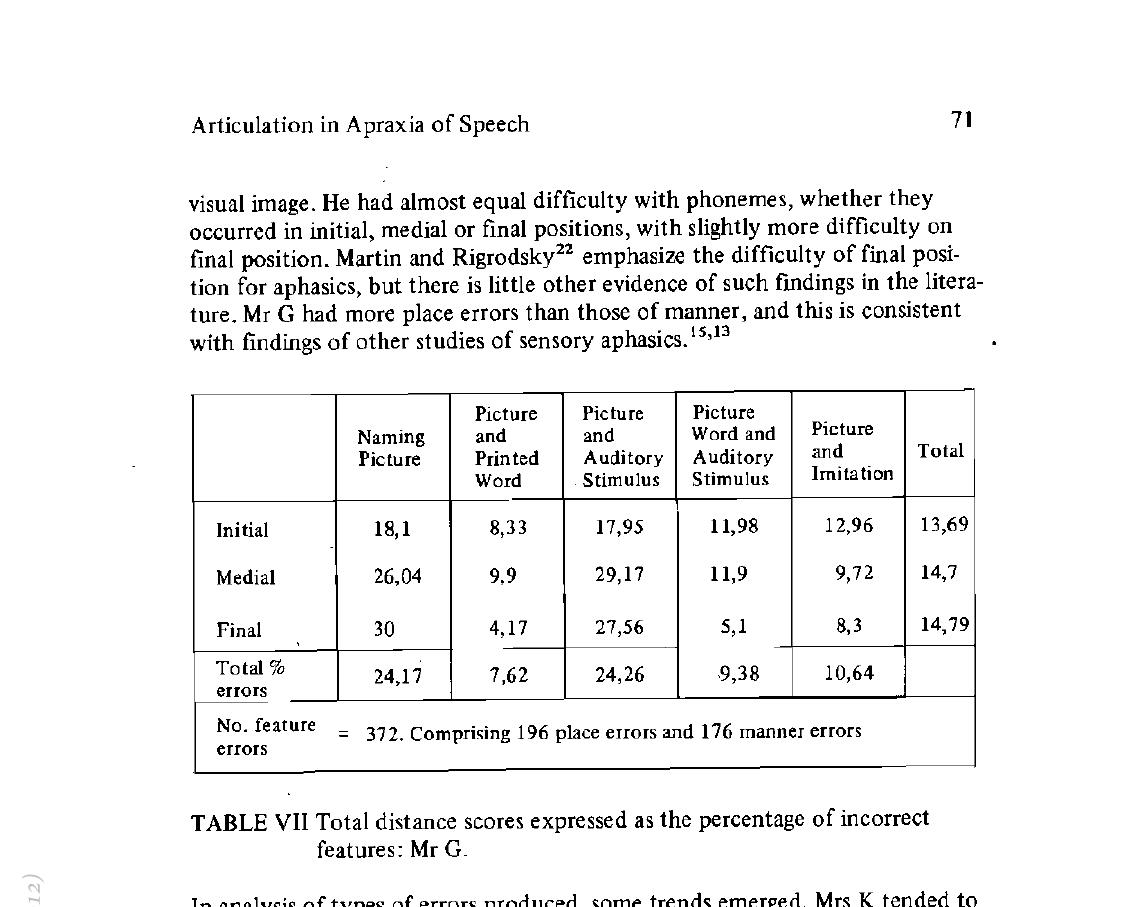
TABLE VII Total distance scores expressed as the percentage of incorrect features: Mr